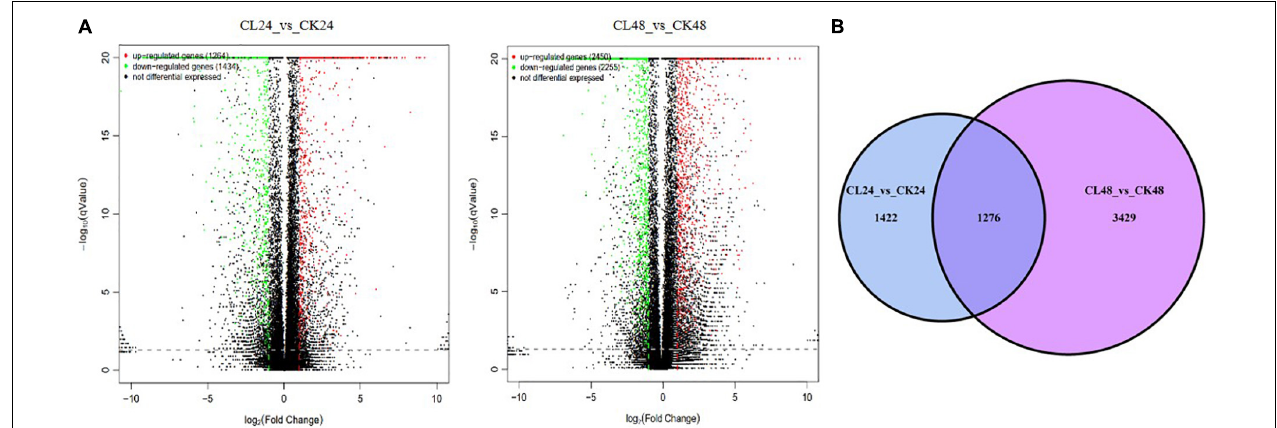
FIGURE 3 | The DEGs between CL24 vs. CK24 and CL48 vs. CK48. Panel (A) represents volcano plot of DEGs between CL24 vs. CK24 and CL48 vs. CK48. Splashes represent different genes, where black indicates the mean number of genes without significant differential expression, red indicates the mean of significantly upregulated genes, and green indicates the mean of significantly downregulated genes. (B) Venn diagram showing the overlap of expressed genes between CL24 vs. CK24 and CL48 vs. CK48. Blue represents CL24 vs. CK24, and purple represents CL48 vs. CK48.